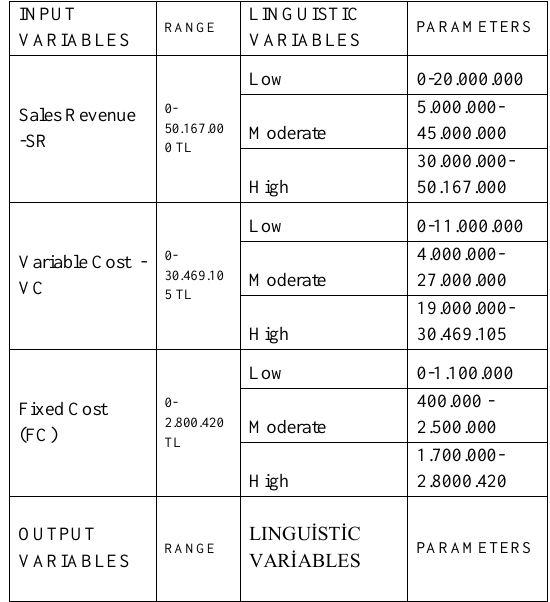
Figure 2. Target Costing Process